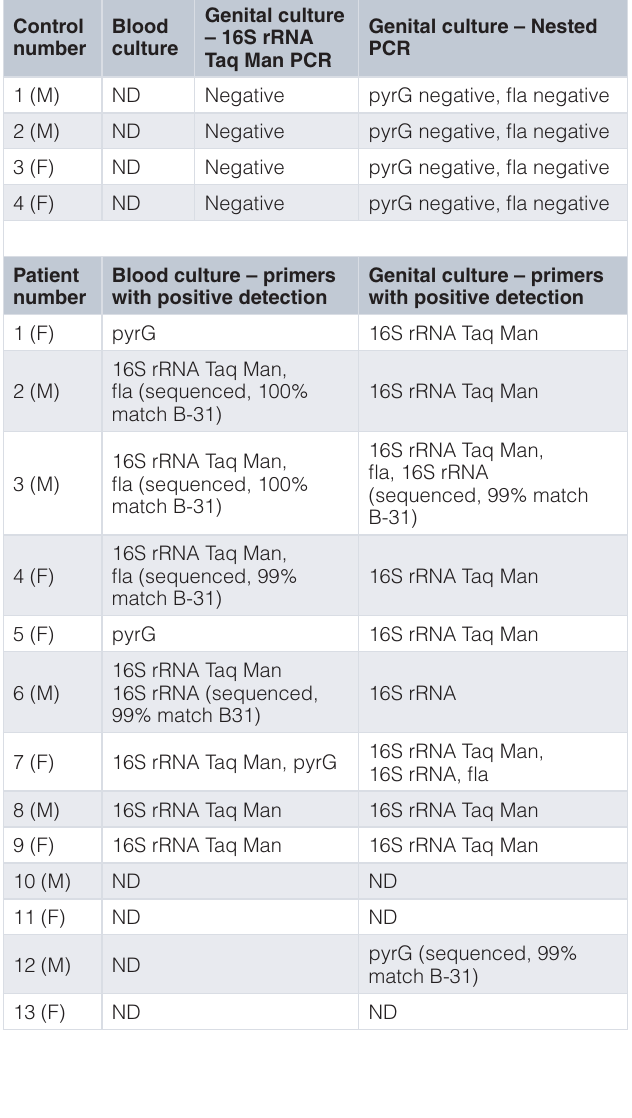
Table 6. Comparison of seminal and vaginal Borrelia gene sequences using BLAST analysis. Sequencing for Patients 6, 7, 10, 11 and 13 was done at Australian Biologics. Sequencing for Patient 12 was done at University of New Haven. See Dataset, data file 6.